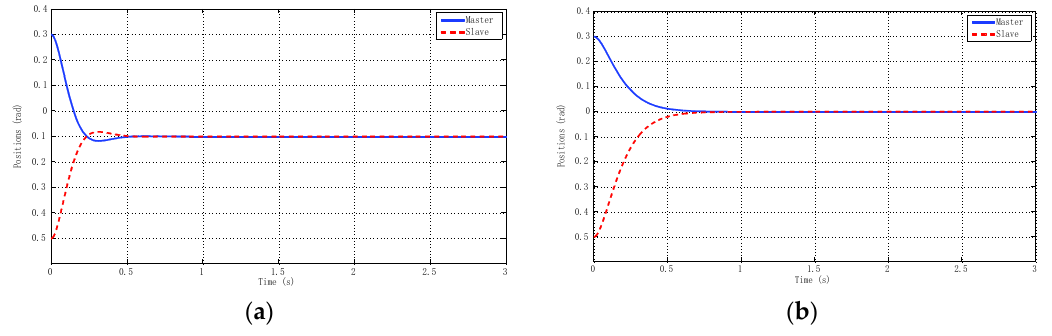
Figure 9. Simulated f h = f e = 0 with h max = 0, d = 0. Positions. ( a ) PE; ( b ) γ-4C.